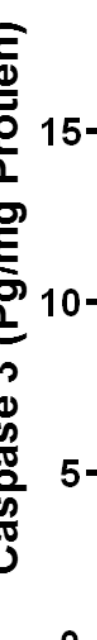
Figure 10. Effect of ICA-phytosomes on caspase-3 content in OVCAR-3 cells. * Significantly different from control at p < 0.05, # significantly different from placebo-phytosomes at p < 0.05, $ significantly Figure 10. E ff ect of ICA-phytosomes on caspase-3 content in OVCAR-3 cells. * Significantly di ff erent different from pure-ICA at p < 0.05. from control at p < 0.05, # significantly di ff erent from placebo-phytosomes at p < 0.05, $ significantly di ff erent from pure-ICA at p <